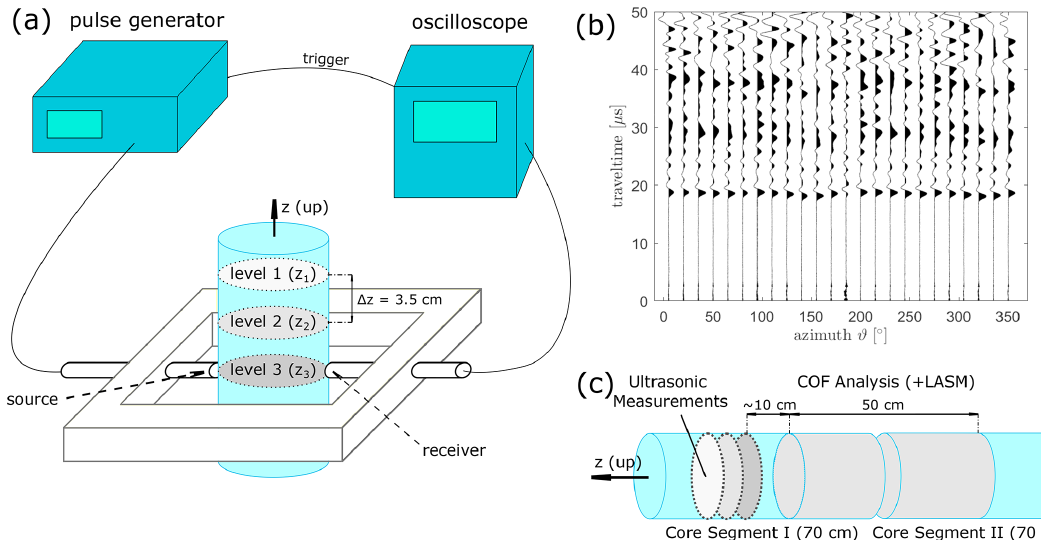
Figure 1. (a) Schematic experimental set-up for ultrasonic measurements on the ice core with tools and devices (amplifiers not shown). (b) Example dataset of seismic traces for horizontal measurements. (c) The segmentation of two adjacent ice core segments depicting the position of the ultrasonic and COF